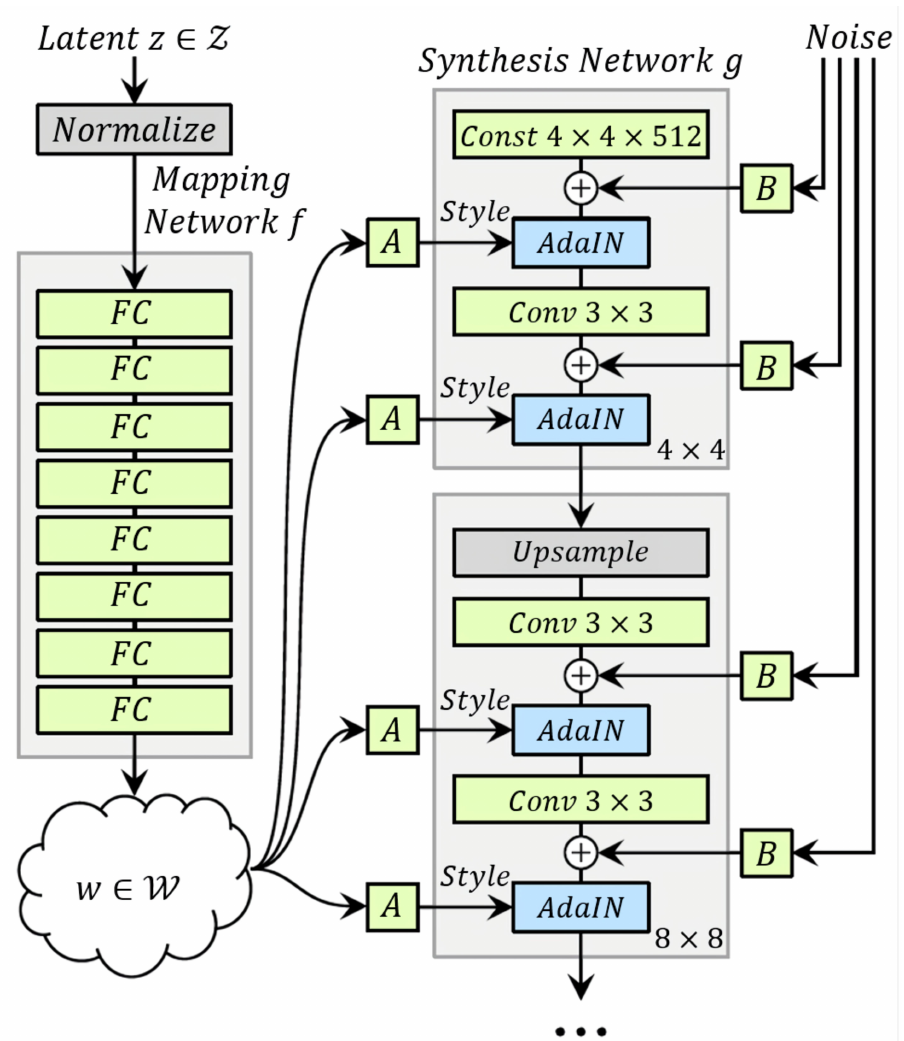
Figure 16. Generator structure of StyleGAN